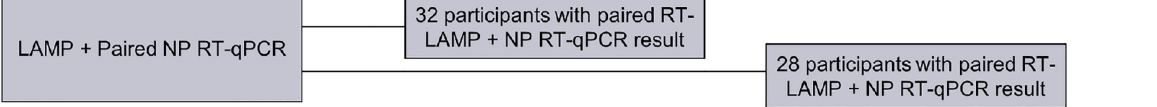
Fig 4. Testing and analysis flowchart by sample type. Flowchart shows the number of participants who were enrolled and confirmed to have SARS-CoV-2 infections, and the corresponding number of samples by type that were collected and analyzed by RT-qPCR and by